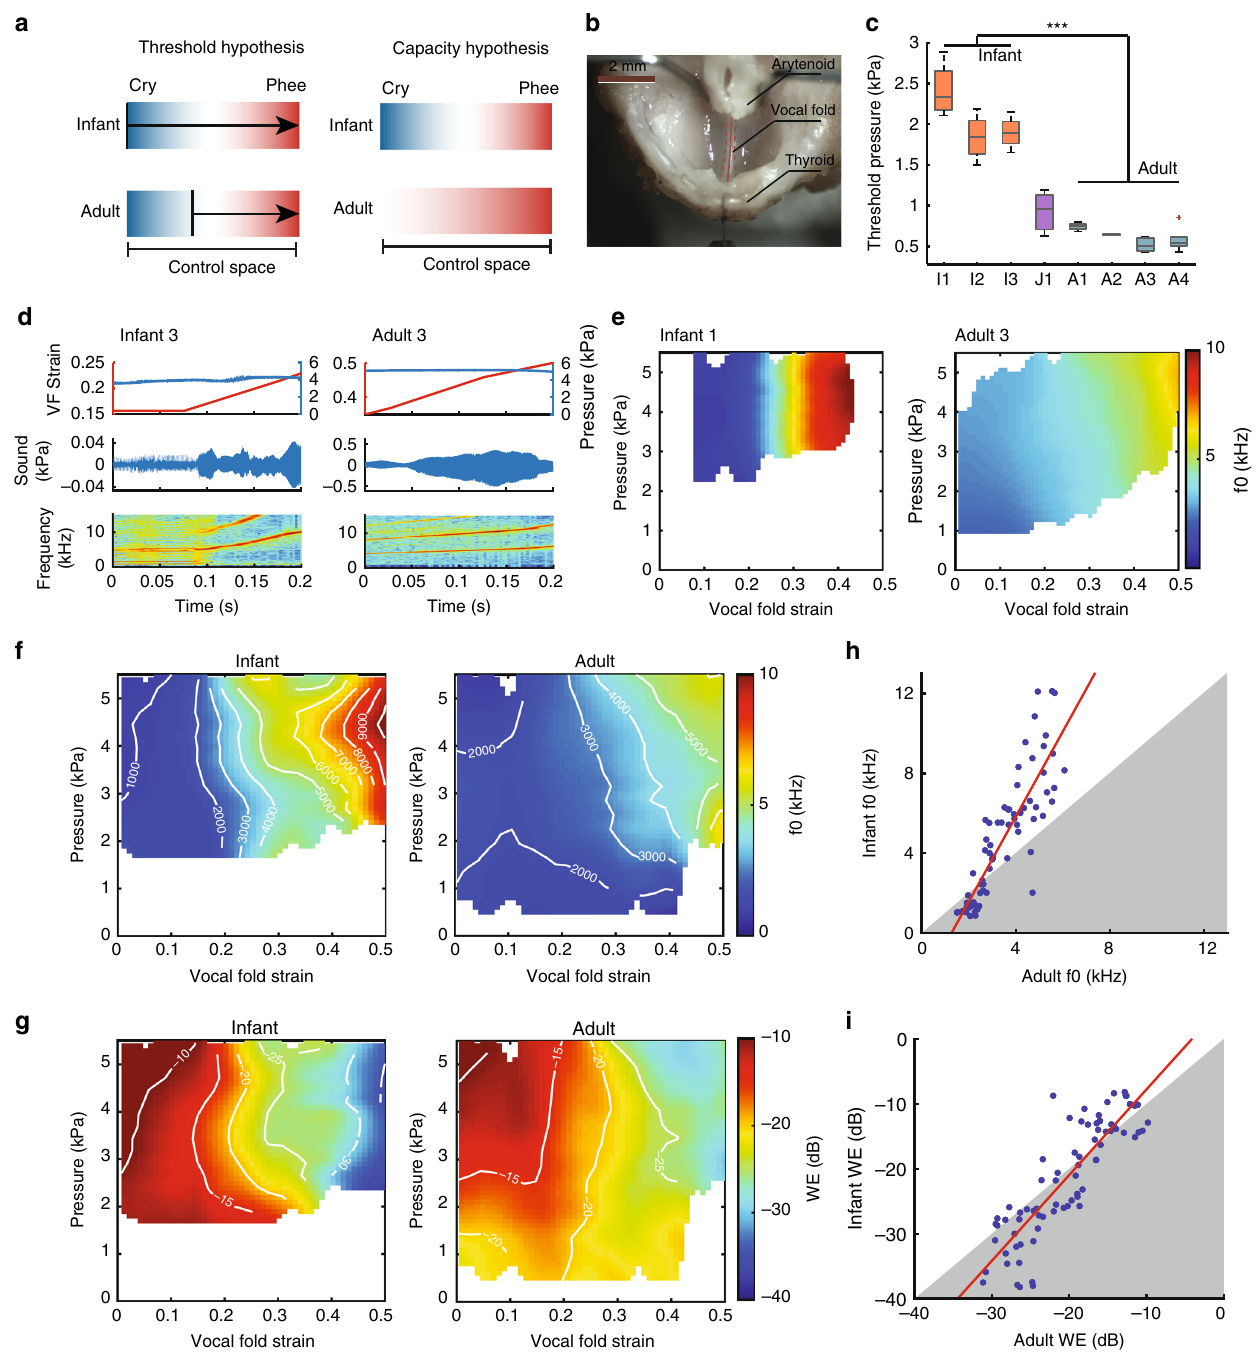
Fig. 2 The infant larynx has greater vocal capacity than the adult larynx. a Two alternative hypotheses for infant cry production. Threshold hypothesis: both the infant and the adult larynges have the same vocal range, but the adult larynx starts phonation at a higher threshold. Capacity hypothesis: the infant larynx has greater capacity than the adult larynx. Color indicates f o . b Excised larynx setup: an infant marmoset larynx mounted on an arti fi cial trachea with arytenoid cartilage adducted and the position of thyroid cartilage manipulated by the lever arm of an ergometer. c Comparison of phonation threshold pressure between infant and adult excised larynges. d Exemplars of sound generated from an infant and an adult larynx while the vocal folds were stretched at fi xed pressures. From top to bottom: the real-time vocal fold strain and subglottal pressure, sound pressure, and sound spectrogram. e f o maps of an infant and an adult larynx in the control space of pressure vs. vocal fold strain. f , g Mean f o maps ( f ) and mean WE maps ( g ) of infant ( n = 3) and adult ( n = 4) larynges. Iso- f o contours (in Hz) and iso-WE contours (in dB) are overlaid, showing that the pressure control is redundant. h , i Comparisons between the infant and adult f o s ( h ) and WEs ( i ) generated at the same pressure and vocal fold strain settings. Slopes signi fi cantly greater than 1 indicate greater capacity of the infant larynx than the adult larynx. Source data are provided as a Source Data fi